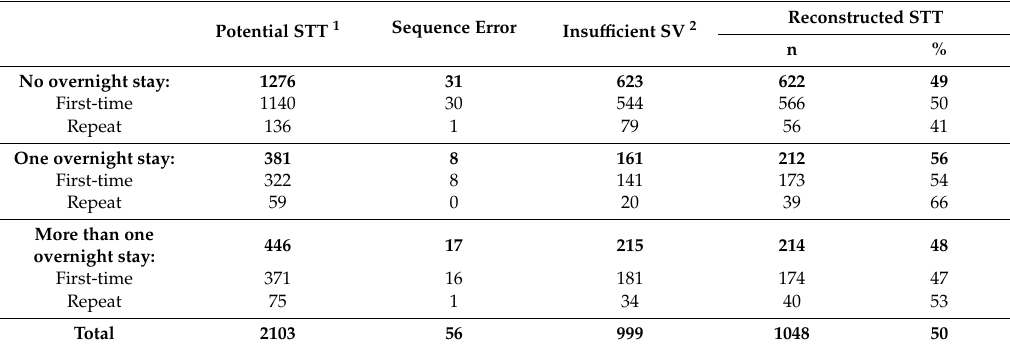
Table 3. Potential spatiotemporal trajectories and final number of spatiotemporal trajectories